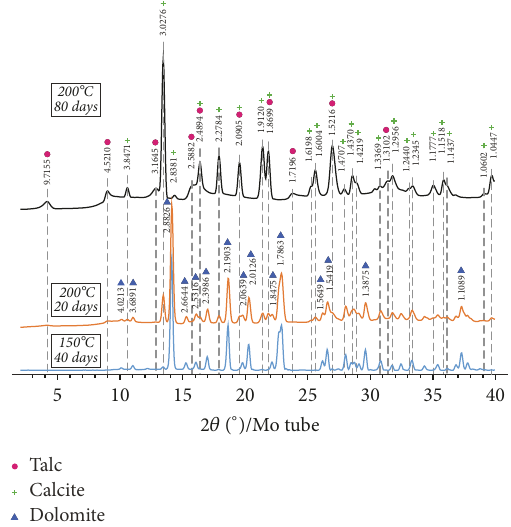
Figure 5: X-ray patterns of the solid relicts in FSCCs containing dolomite and water after heating at 150 ∘ C for ∼ 40 days (lower blue line) and at 200 ∘ C for ∼ 20 days (middle orange line) and ∼ 80 days (upper black line).